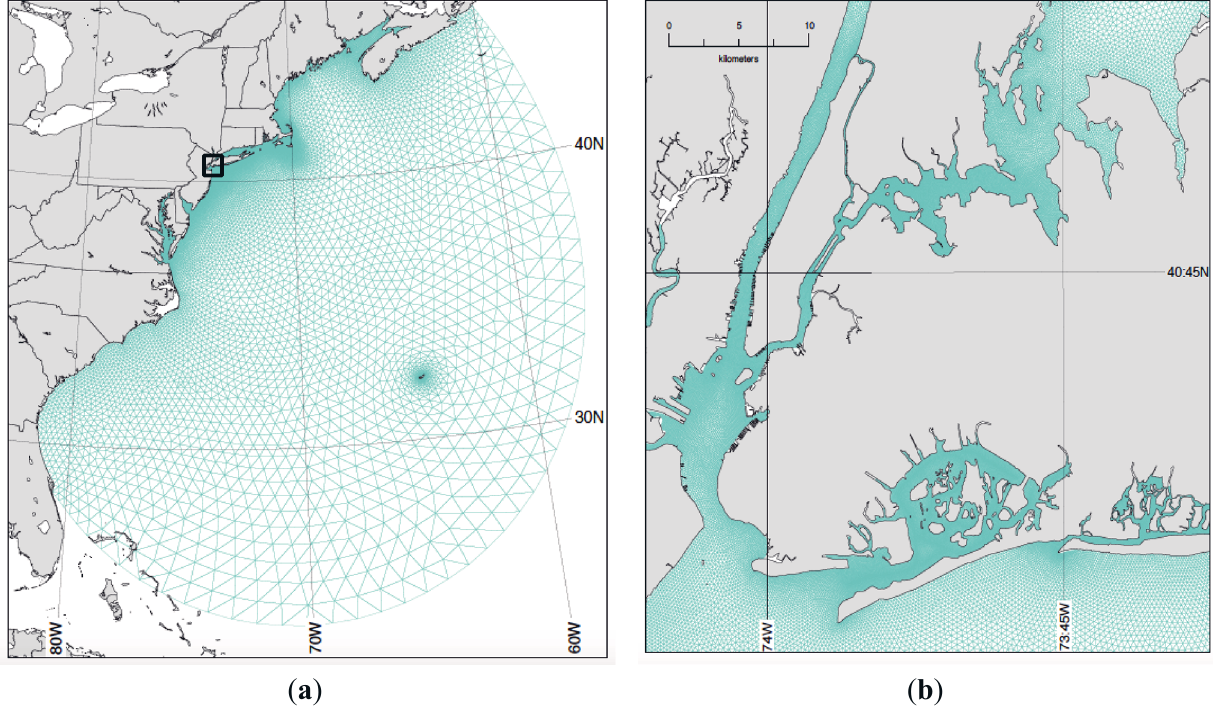
Figure 2. ( a ) Domain of the ADCIRC model, extending from mid State of Florida (FL) to the Atlantic coast of Nova Scotia, Canada (NS), indicated by the black nodes. ( b ) Zoom in for the small black box in ( a ) for the region around NYC and western Long Island. The sizes of elements range from ~7 m in inner bays and estuaries to ~70 km along the outer ocean boundary. The grid has 184,534